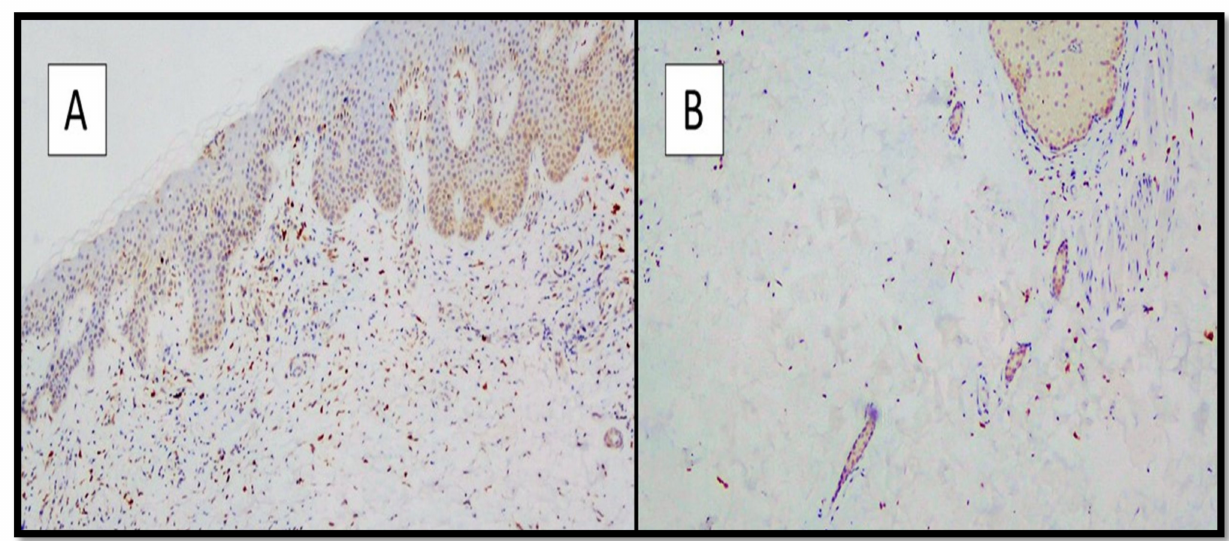
Figure 6. ( A ) Preparation for immunostaining with anti-TMPRSS2 antibody from skin samples of SARS-CoV-2-positive patients. Note the negativity of the immunolabeling of the epidermal keratinocytes (Immunohistochemistry anti-TMPRSS2, original magnification: 4 × ). ( B ) Detail of image A showing negativity of the TMPRSS2 immunolabeling of some adenomeres of eccrine sweat glands. (Immunohistochemistry anti-TMPRSS2, original magnification: 20 ×